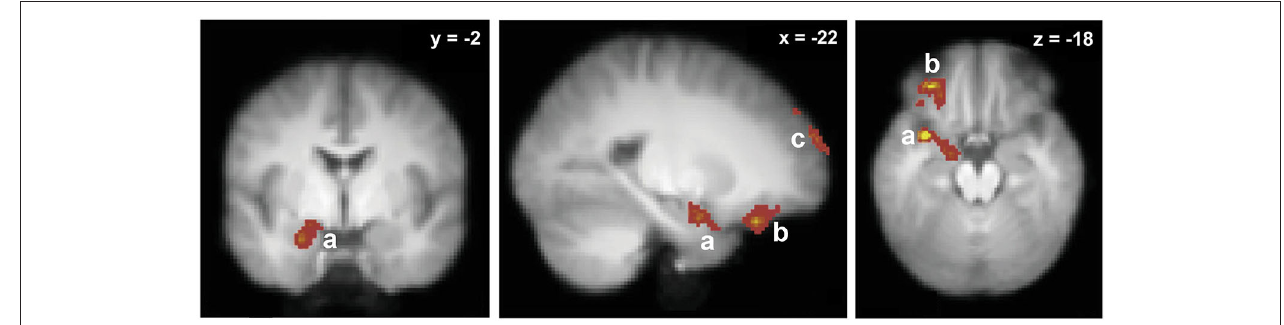
FIGURE 4 | Neural basis of odor recognition through verbal label . Brain activations specific to olfactory modality (in comparison with object-verbal recognition). a, Left insula/amygdala/piriform cortex; b, left orbitofrontal cortex; c, left frontal pole (adapted from Lehn et al.,